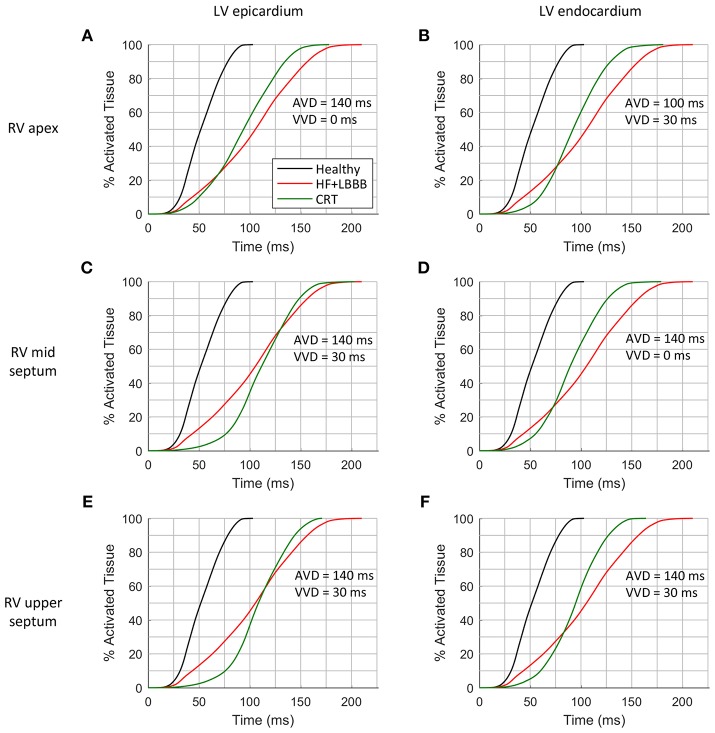
Cumulative frequency histograms of the normalized percentage of activated tissue. The curves correspond to healthy (black), HF + LBBB (red) and CRT (green) scenarios. The best CRT configurations (shortest QRSd) for the three locations of the RV lead were tested: RV apex with epicardial (A) and endocardial (B) LV lead stimulation; RV mid septum with epicardial (C) and endocardial (D) LV lead stimulation; and RV upper septum with epicardial (E) and endocardial (F) LV lead stimulation.